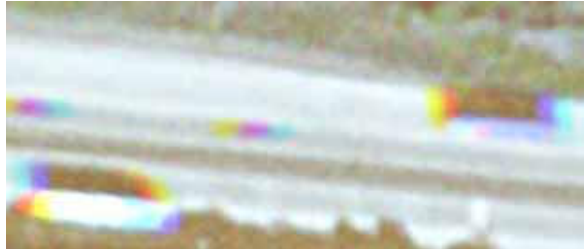
Figure 4: Moving cars and trucks on a highway in SkySat Basic Analytic